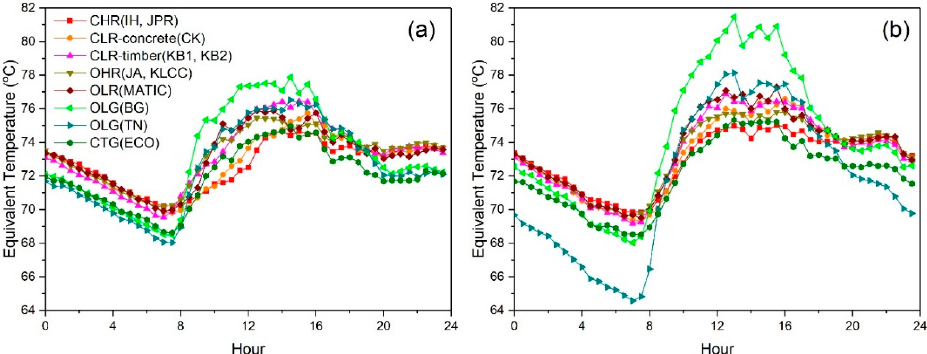
Figure 10. Diurnal variation of calculated equivalent temperature in wet ( a ) and dry ( b ) seasons for different land use